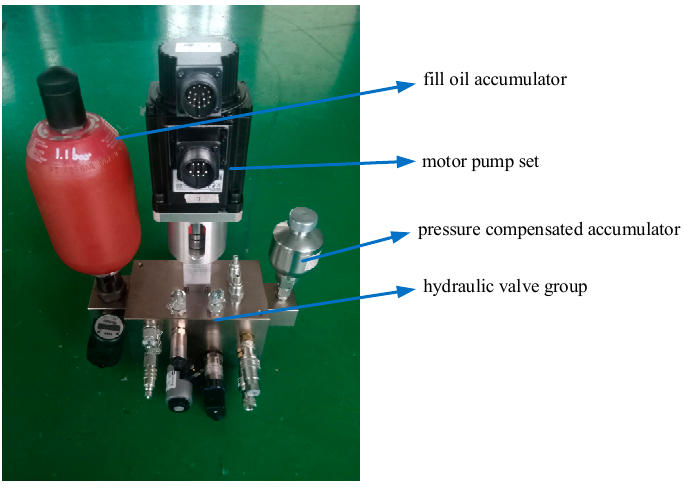
Figure 11. Hydraulic control unit.